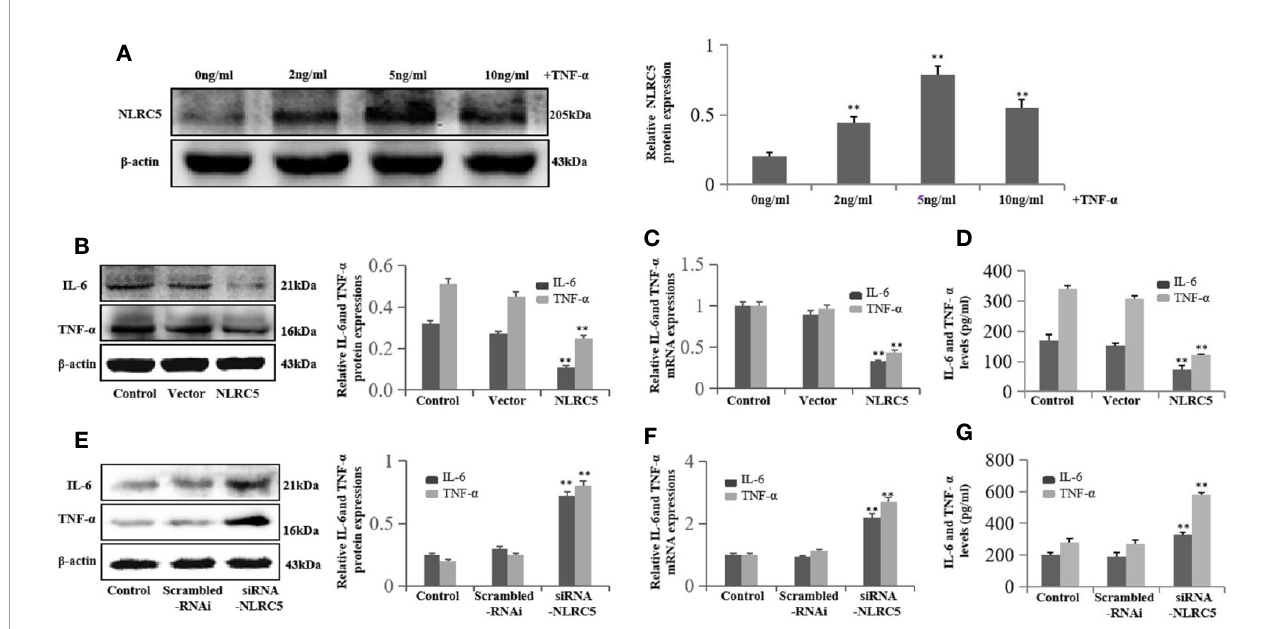
FIGURE 5 | NLRC5 inhibits in fl ammation in EESCs (n = 7). (A) Representative western blotting showing 2, 5, and 10 ng/ml of TNF- a all induced NLRC5 expressions in EESCs compared with control group, and the highest protein levels of NLRC5 were reached at 5 ng/ml after 24 h induced by TNF- a treatment (**P < 0.01 vs. control group). (B – D) Representative western blotting, qRT-PCR, and ELISA showing over-expression of NLRC5 by transfection with NLRC5 plasmid signi fi cantly inhibited IL-6 and TNF- a expressions when compared with vector group (**P < 0.01 vs. vector group). (E – G) Representative western blotting, qRT-PCR, and ELISA showing inhibition of NLRC5 by transfection with siRNA-NLRC5 signi fi cantly promoted IL-6 and TNF- a expression when compared with scrambled-RNAi group (**P < 0.01 vs. scrambled-RNAi group). The expression levels of mRNA were normalized with respect to b -actin and were calculated using the 2 - DD Ct method. The protein expression levels were quanti fi ed by Image J software and normalized to b -actin protein levels. The results are represented as the mean ± SEM from at least three independent